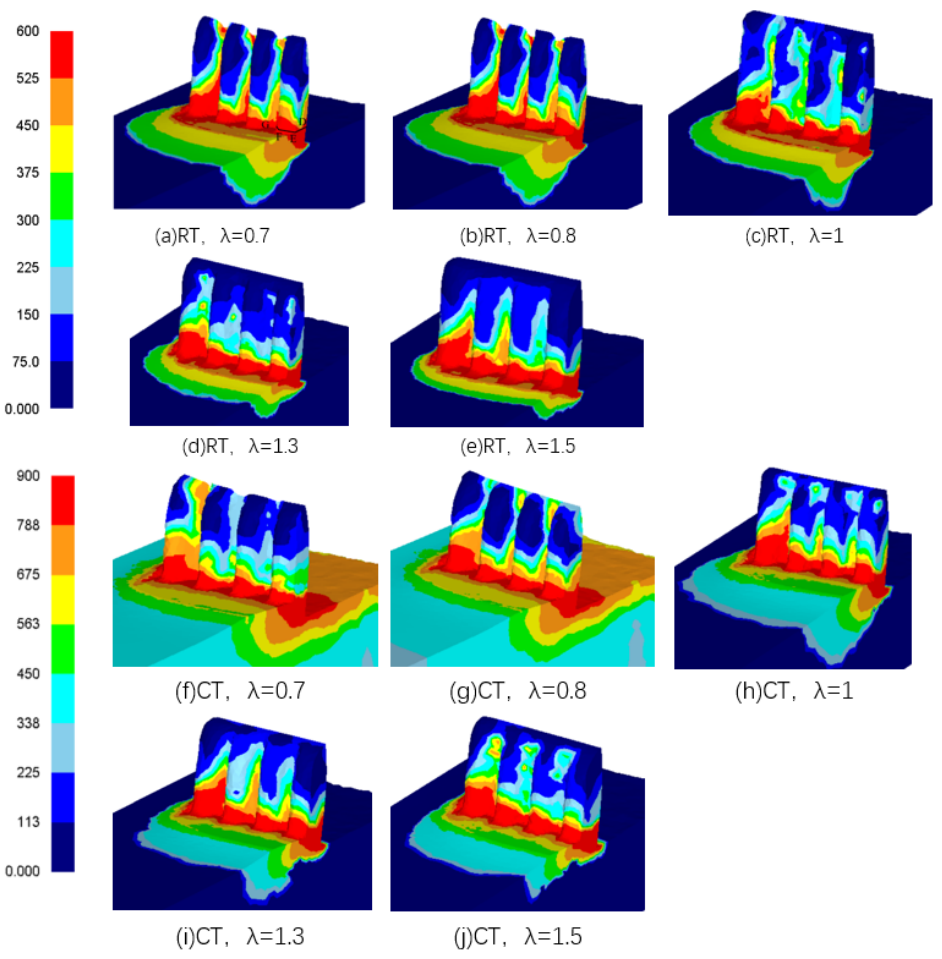
Figure 4. Effective stress distribution of the fins under different conditions.